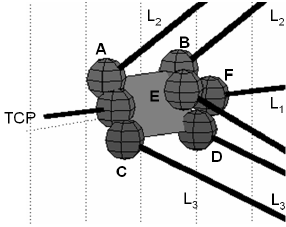
Figure 4: Kinematic platform parameters.